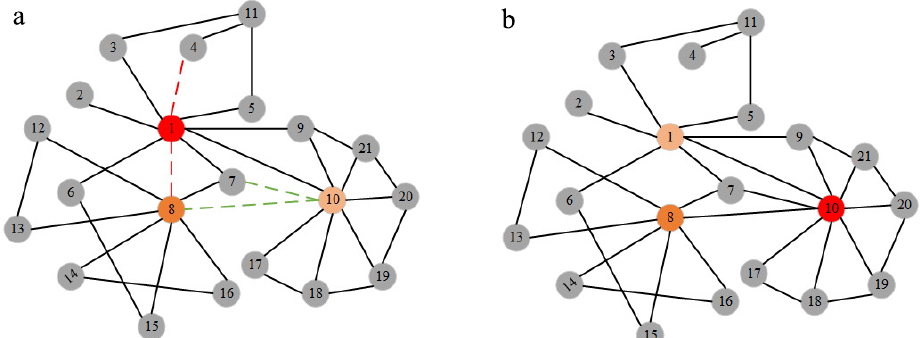
Figure 5. ( a ) shows the construction process of the adversarial hiding deception network, the hidden edges are represented by red dashed lines and the deceptive edges are represented by green dashed lines, the higher the degree value the darker the node color. ( b ) shows the constructed adversarial hiding deception network, the higher the degree value the darker the node